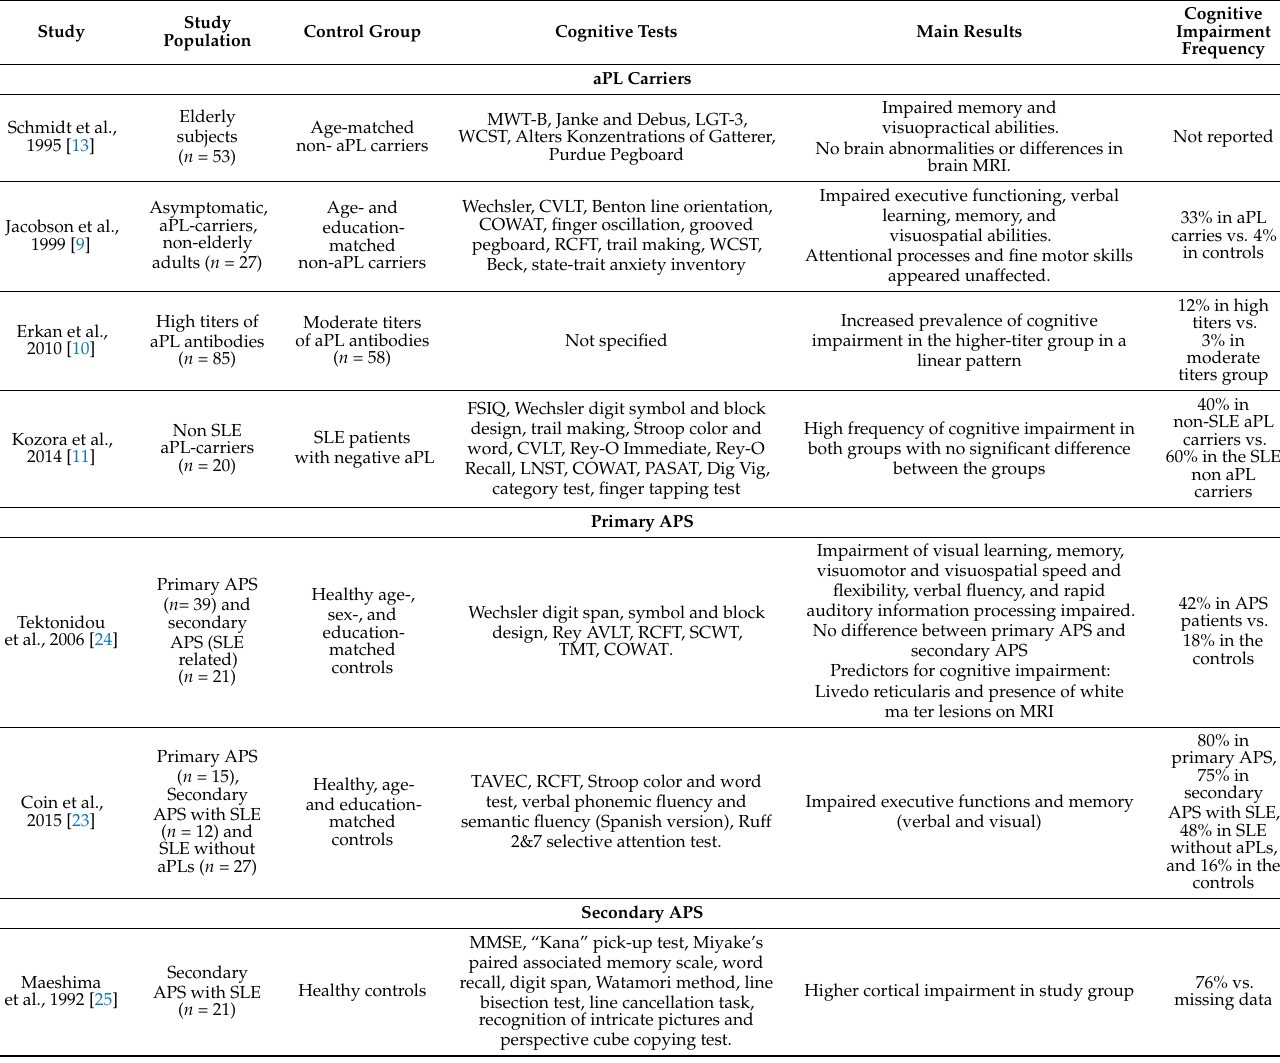
Table 2. Cognitive impairment in aPL carriers and APS